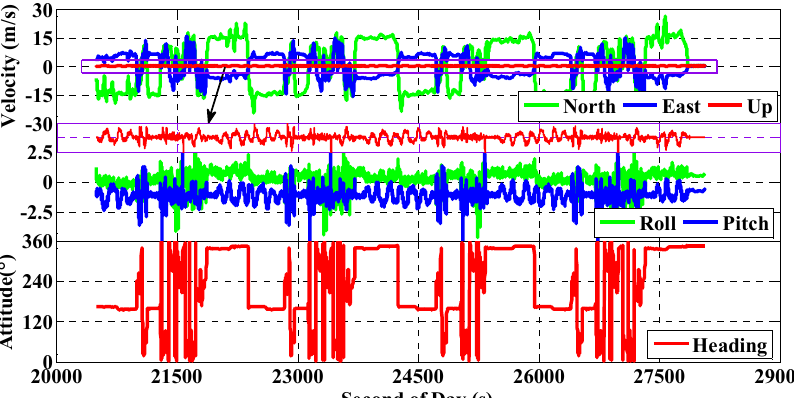
Figure 2. Velocities ( top ) and attitudes of land vehicle experiment on June 19, 2013 in Wuhan, China (the middle subfigure shows roll and pitch components, and the bottom subfigure shows heading direction); the purple box shows the enlarged velocity time series of Up direction in the top subfigure.